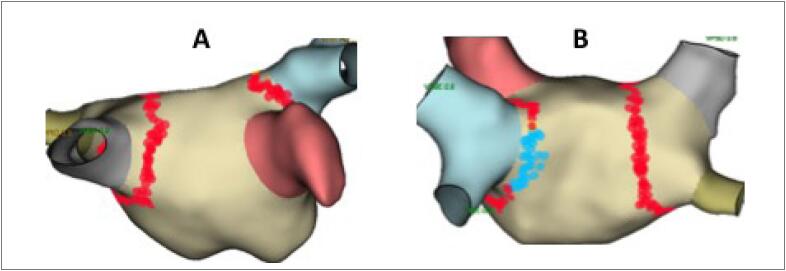
Radio Frequency Applications. Images generated by left atrial geometric reconstruction using an electroanatomical mapping system (Ensite/NAVX – St. Jude Medical/Abbott). A – Previous view. Dots in red show the radiofrequency applications. B – Posterior view. Blue dots show locations of radiofrequency applications where esophageal temperature increases.